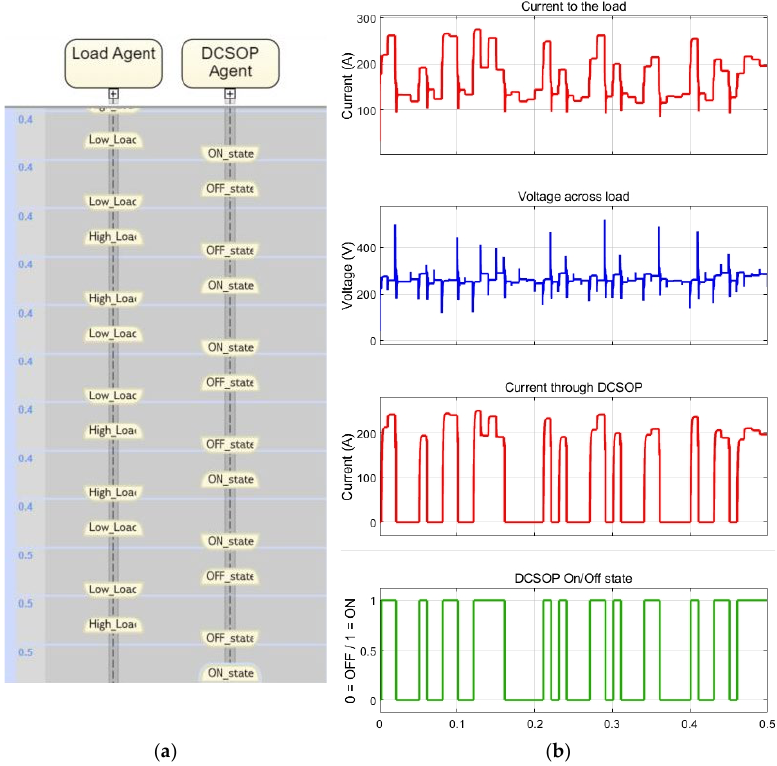
Figure 21. ( a ) Agent states sequence and ( b ) results from DC microgrid simulation over a period of 0.5 s, as shown in the horizontal axis.